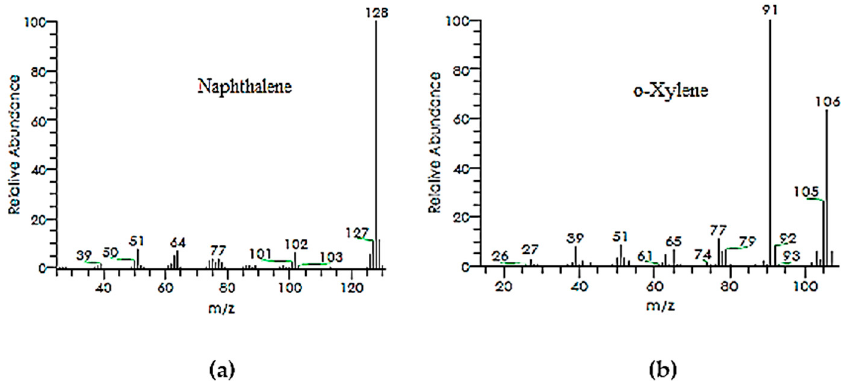
Figure 7. GC chromatogram of orange II after B. subtilis degradation. Table 4. Identified metabolites in degraded dye mixture from GCMS results.